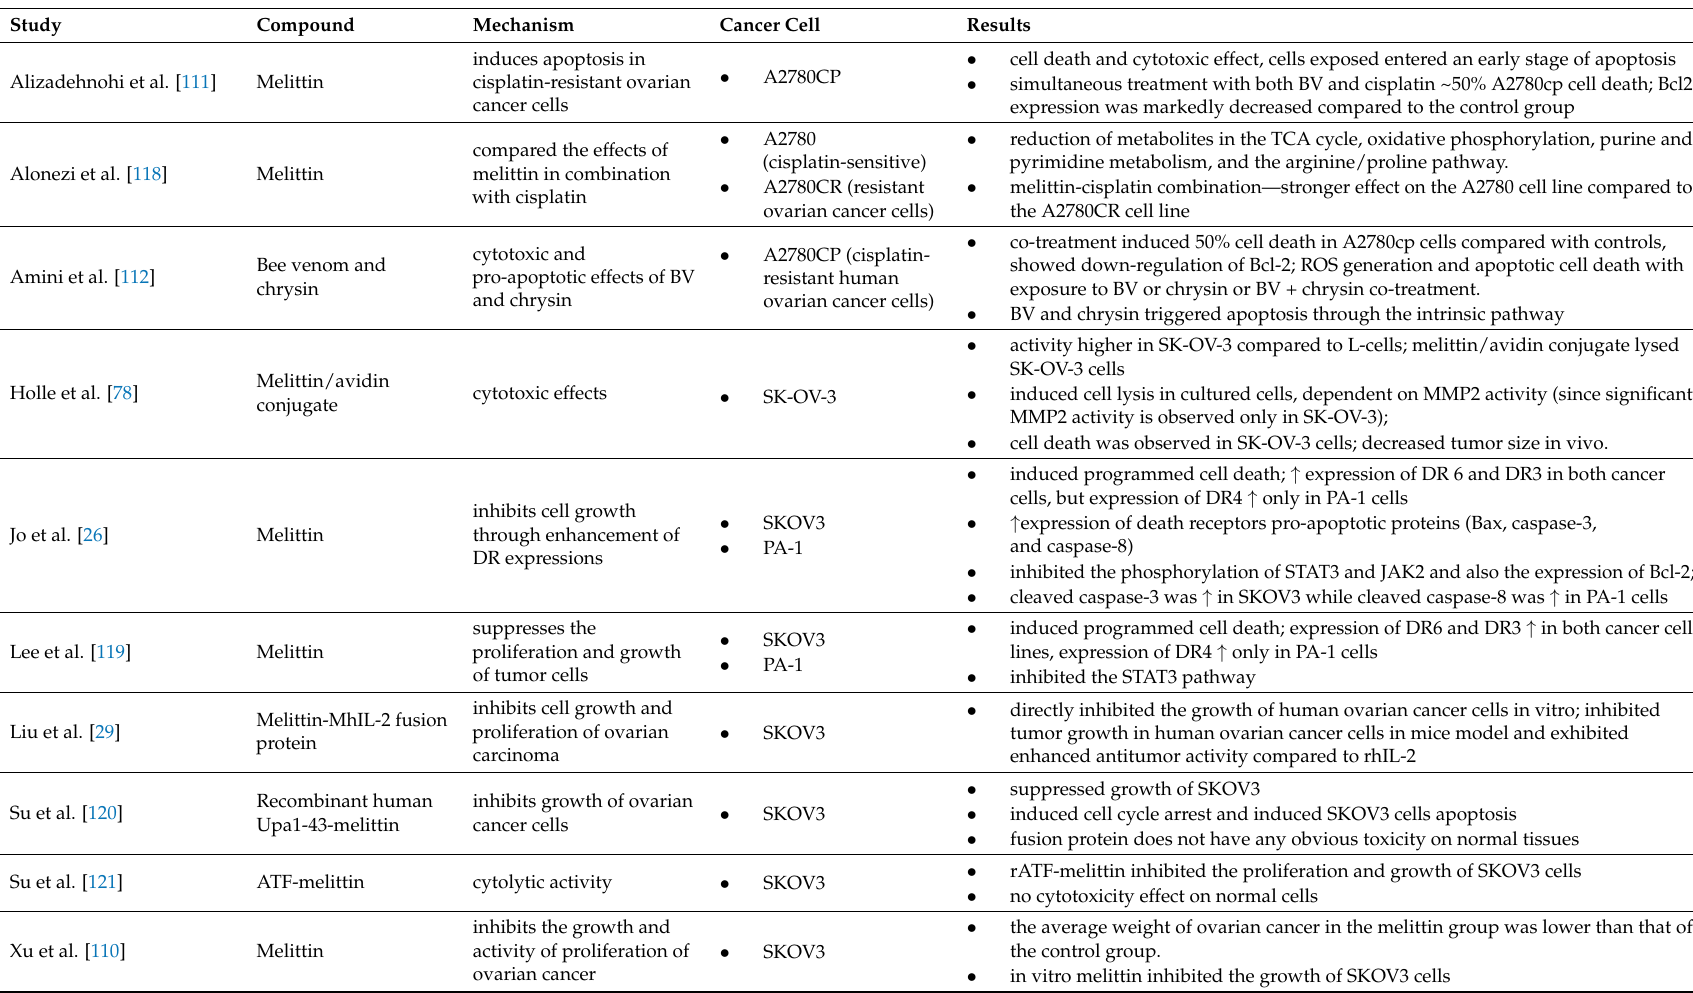
Table 3. Studies of the effects of bee venom and their components on ovarian cancer